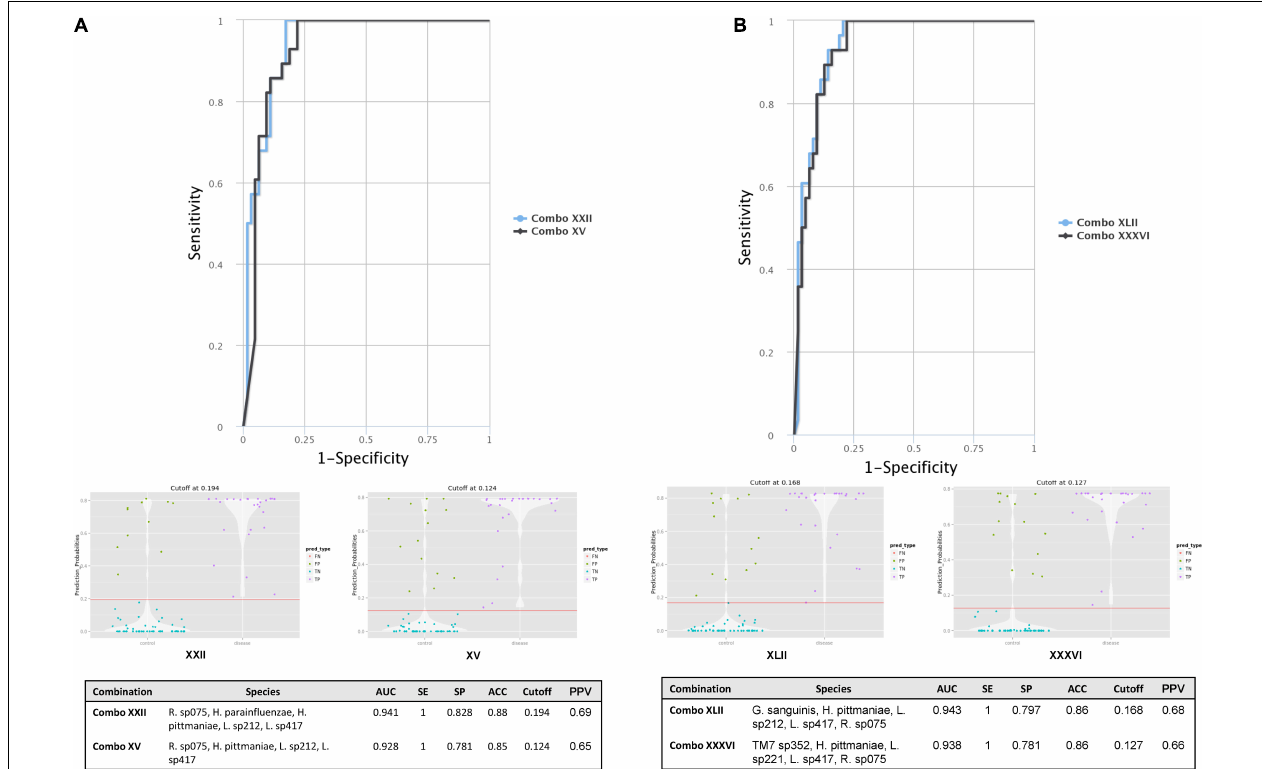
FIGURE 4 | HNC HPV+ vs. HNC HPV– CombiROC analysis using RA and log(RA + 1) transformed abundance data. (A) CombiROC analysis for biomarkers with AUC > 0.75 on RA data. (B) CombiROC analysis for biomarkers with AUC > 0.75 on log(RA + 1) data. Significant ( α = 0.05) CombiROC program-generated receiver operator characteristic (ROC) curves for (A) RA data and (B) log(RA + 1) transformed abundance data of candidate microbial biomarkers (AUC > 0.75; n = 10 bacterial species) identified via MedCalc Software for Grp-All HPV+ vs. HPV– group are shown. (A) ROC curves, violin plots, and descriptive statistic summary table for the best two combinations from 10 potential markers using the RA are shown. “Combo XXII” consists of a combination of the markers Ruminococcaceae sp075 , Haemophilus parainfluenzae , Haemophilis pittmaniae , Leptotrichia sp212 , and Leptotrichia sp417 (ROC curve blue line). “Combo XV” contains markers Ruminococcaceae sp075 , H. pittmaniae , Leptotrichia sp212 , and Leptotrichia sp417 (ROC curve black line). (B) ROC curves, violin plots, and descriptive statistic summary table for the best two combinations from 10 potential markers using the log(RA + 1) transformed data are shown. “Combo XLII” contains potential markers Gemella sanguinis , H. pittmaniae , Leptotrichia sp212 , and Ruminococcaceae sp075 (ROC curve blue line). “Combo XXXVI” consists of species probes TM7 G1 sp352 , H. pittmaniae , Leptotrichia sp221 , Leptotrichia sp417 , and Ruminococcaceae sp075 (ROC curve black line). Cut-off refers to the optimal value or the highest true positive rate that has the lowest false positive rate. FN, false negative; FP, false positive; TN, true negative; TP, true positive; AUC, area under the curve; SE, sensitivity; SP, specificity; ACC, accuracy; PPV, positive predictive